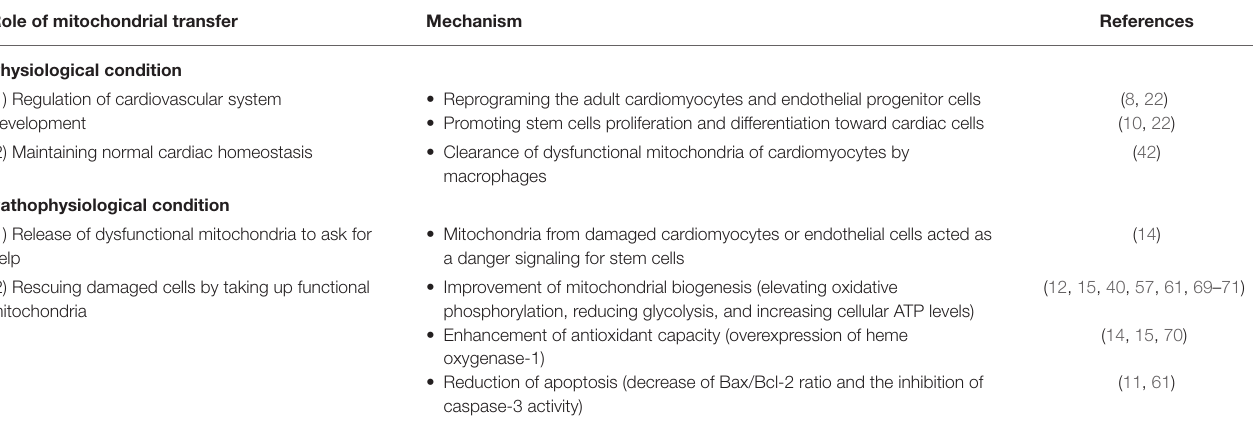
TABLE 3 | Role of mitochondrial transfer under physiological and pathophysiological